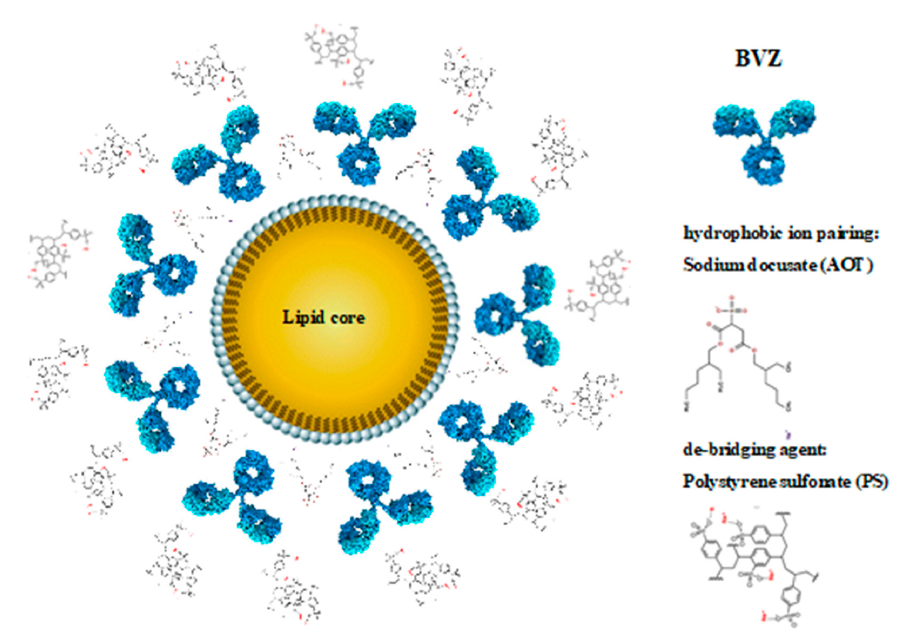
Figure 7. Scheme of the interaction between Intralipid ® (IL) and bevacizumab (BVZ).